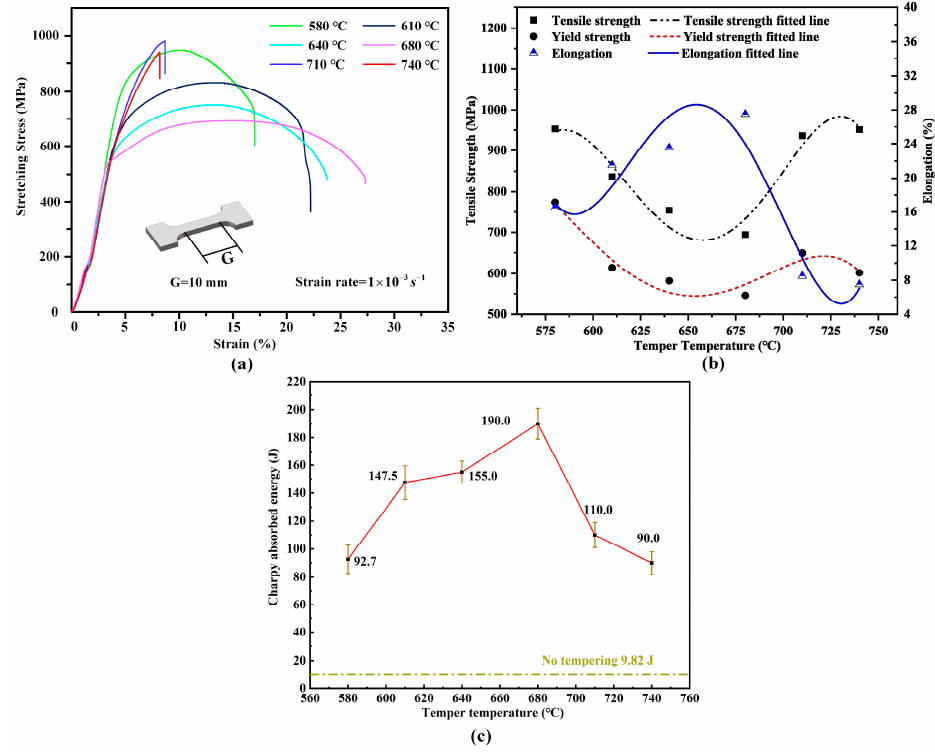
Figure 7. Mechanical properties of 35CrMo steel at di ff erent tempering temperatures. ( a ) Tensile stress–strain curves, ( b ) strength and elongation curve, and ( c ) impact properties curve.